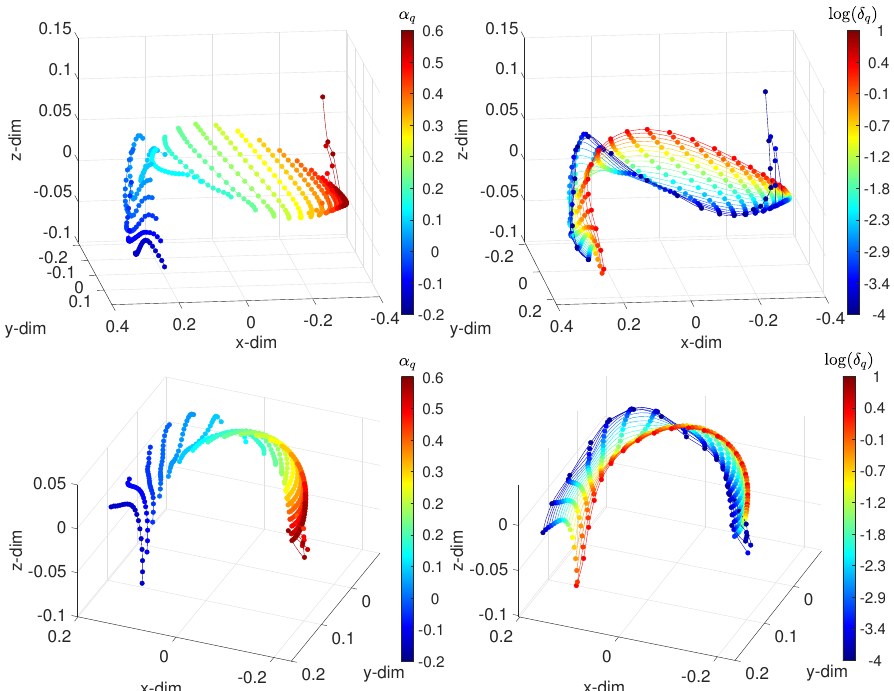
Figure 7. The 3-dim MDS locus for the FVSC-ISM, assessing the time domain-behavior, with the distances: ( top ) Arccosine ( t ) ( t ) ( t ) ) ; and ( bottom ) Jaccard d ( v ( t ) ) . The points represent the test cases. On the left, lines connect points of d 1 ( v , v , v 2 i j i j constant δ , and each color corresponds to points of constant α . On the right, lines connect points of constant α , and each color corresponds to points of constant δ . The fractional order α q ∈ [ − 0.2,6 ] , and the width of the band δ q ∈ [ 10 − 4 ,10 1 ] .